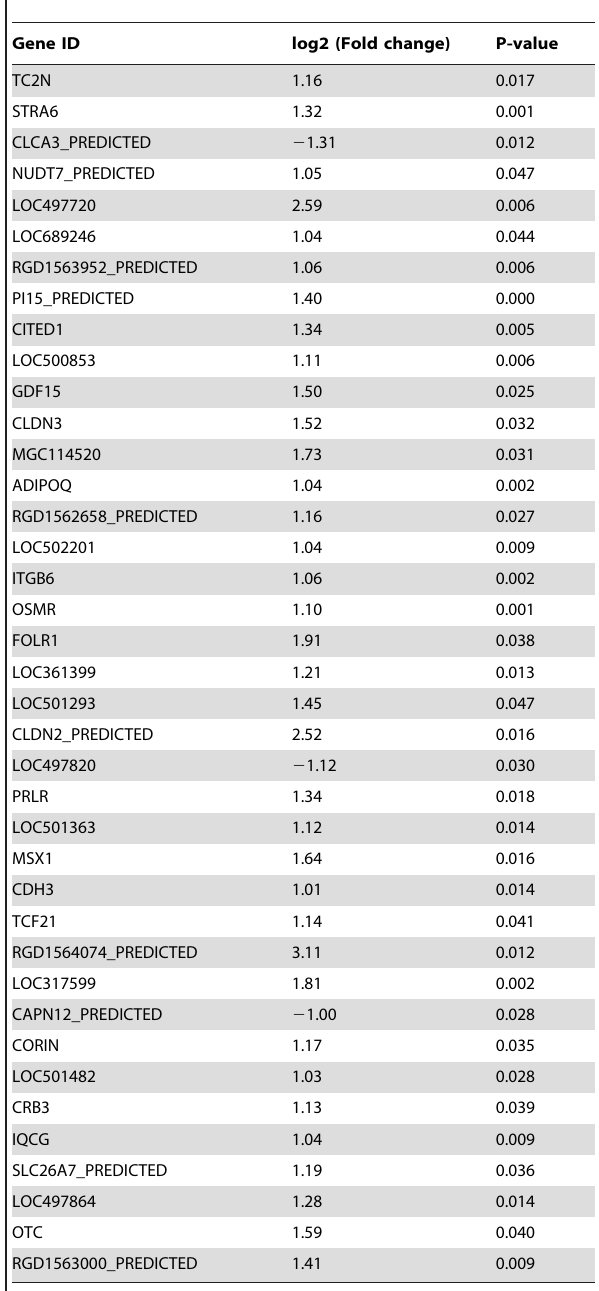
Table 1. List of genes changed after two weeks of restraint treatment (2WSTRESS vs.